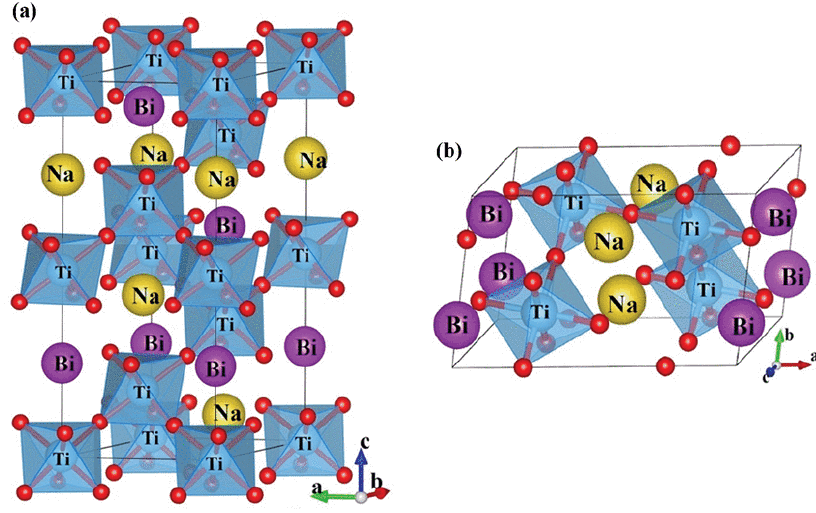
Figure 1. Crystal structure models of ( a ) rhombohedral R 3 c (hexagonal setting); and ( b ) monoclinic Cc phases (from reference [39], Copyright from The American Physical Society 2013). Cc phases (from reference [39], Copyright from The American Physical Society